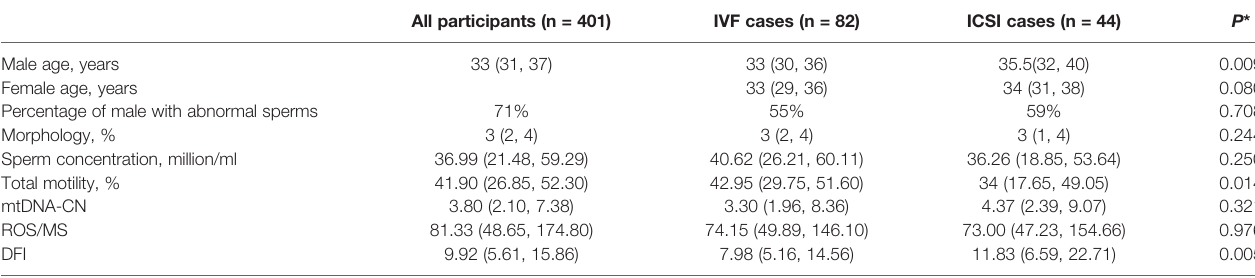
TABLE 1 | Sperm parameters and measurements in all participants and ART cases. All participants (n =